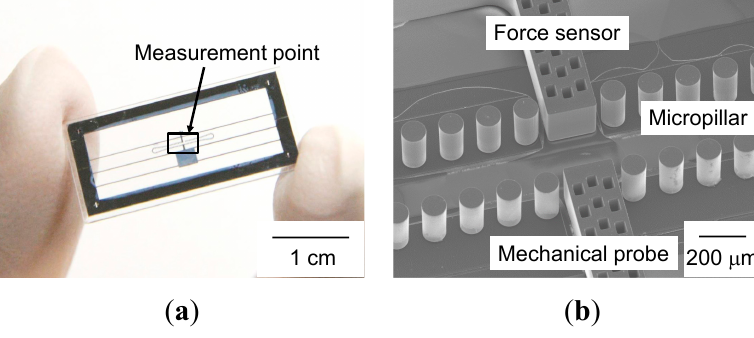
Figure 5. A fabricated chip: ( a ) Photograph of chip; ( b ) scanning electron microscope (SEM) image of the measurement